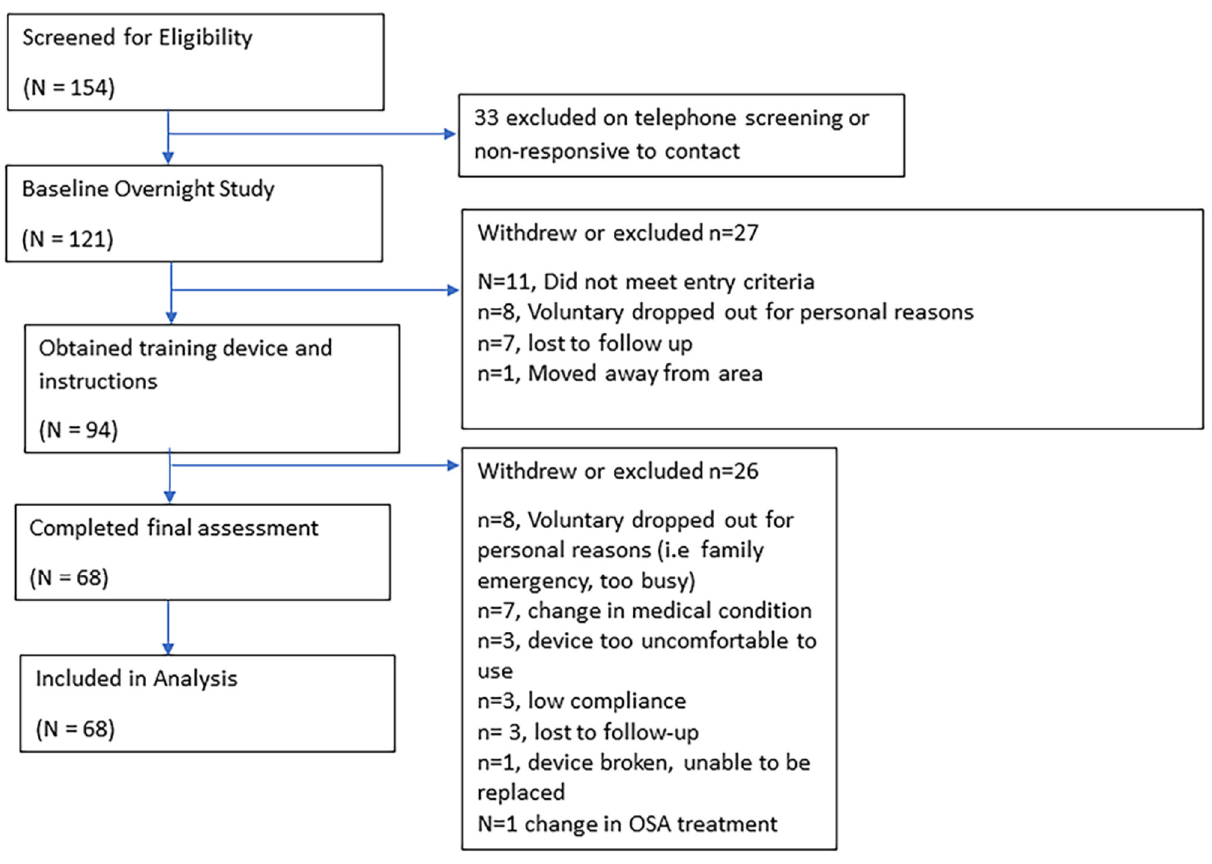
Figure 2. Enrollment flowchart.